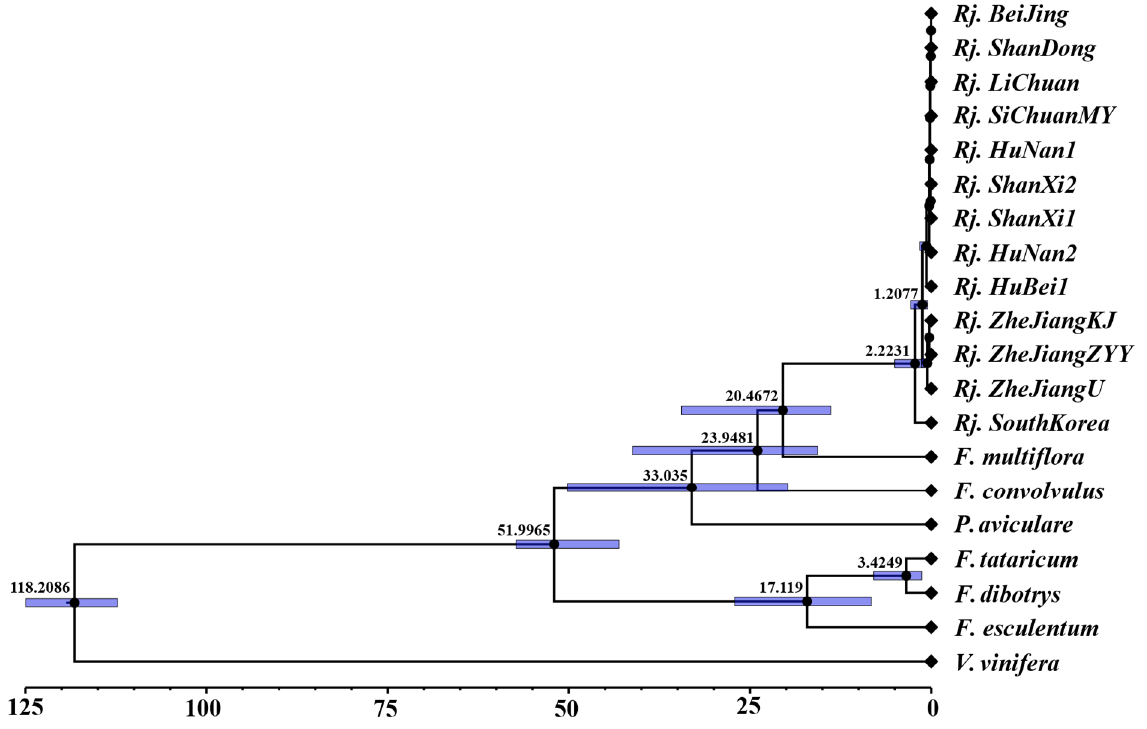
Figure 6. Divergence times of R. japonica and other plants based on shared protein-coding genes with three priors. The mean divergence times of the nodes are shown next to the nodes, and the blue bars correspond to the 95% highest posterior density (HPD); X -axis unit, million years ago (MYA)